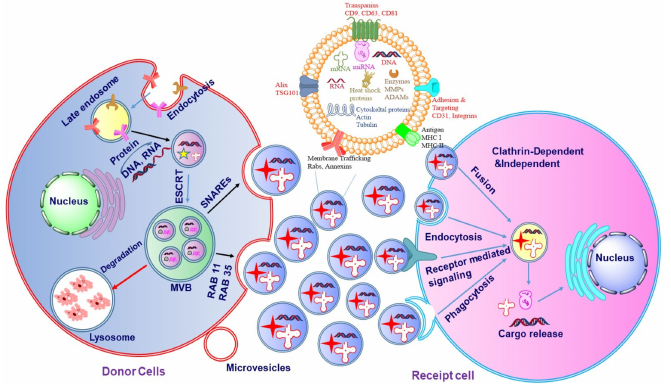
Figure 3. The mechanism of exosome biogenesis. The biogenesis of exosomes is initiated with endo- cytosis which includes cell membrane inward budding and enclosing of biologically active cargos, which further leads to the development of the endosome. The enclosed cargos are then categorized into smaller vesicles which bud from the perimeter membrane into endosome lumen forming multi- vesicular bodies (MVBs). Further, MVBs either merge with the lysosome for degeneration or with the inner plasma membrane through RAB or soluble N-ethylmaleimide-sensitive factor attachment protein receptors (SNAREs) to release